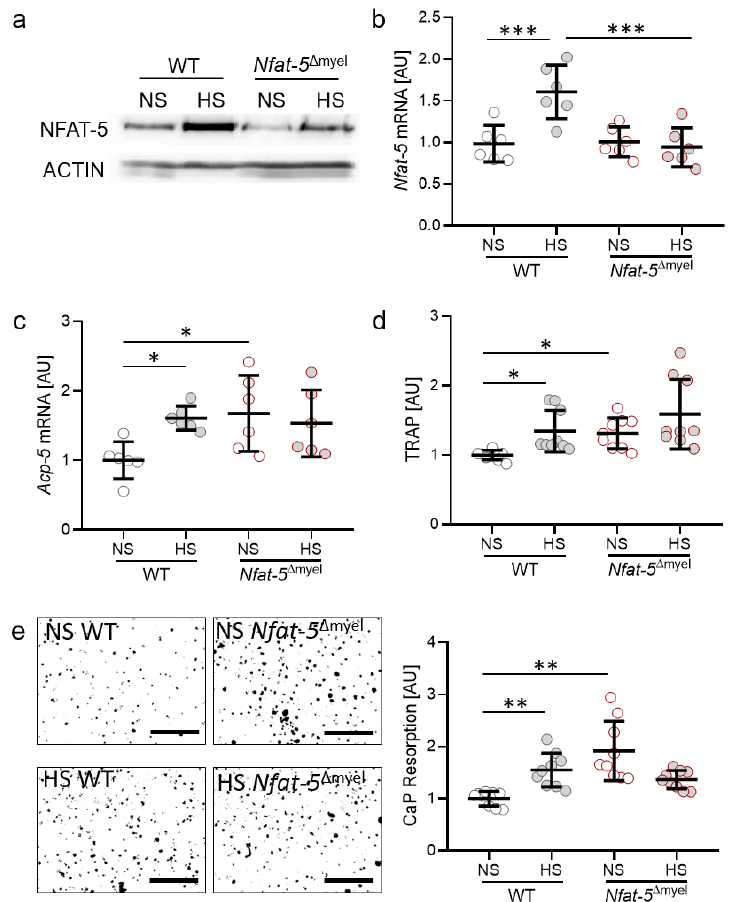
2.4. Impact of the Osmoprotective Transcription Factor NFAT-5 on Osteoclast Activity The transcription factor NFAT-5 (nuclear factor of activated T cells 5) plays an im- portant role in the osmoprotective adaption of cells and tissues to high salt conditions. Therefore, we investigated the role of NFAT-5 on osteoclast activity during salt treatment. Osteoclasts were differentiated from bone-marrow-derived monocytes (BMMs) derived from Nfat-5 Δmyel and control mice (WT). We determined increased NFAT-5 protein expres- sion under HS conditions in osteoclasts from WT mice, whereas this effect was abolished in osteoclasts from Nfat-5 Δmyel mice (Figure 4a).